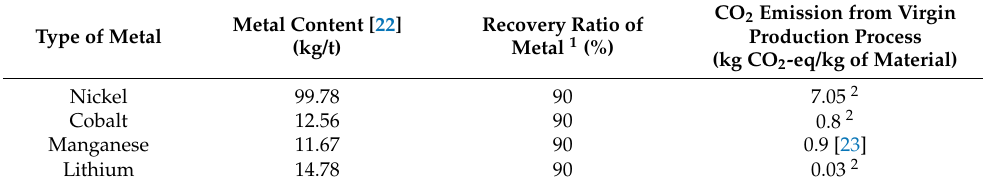
Table 7. Data used for quantizing GHG savings from recovery of materials.